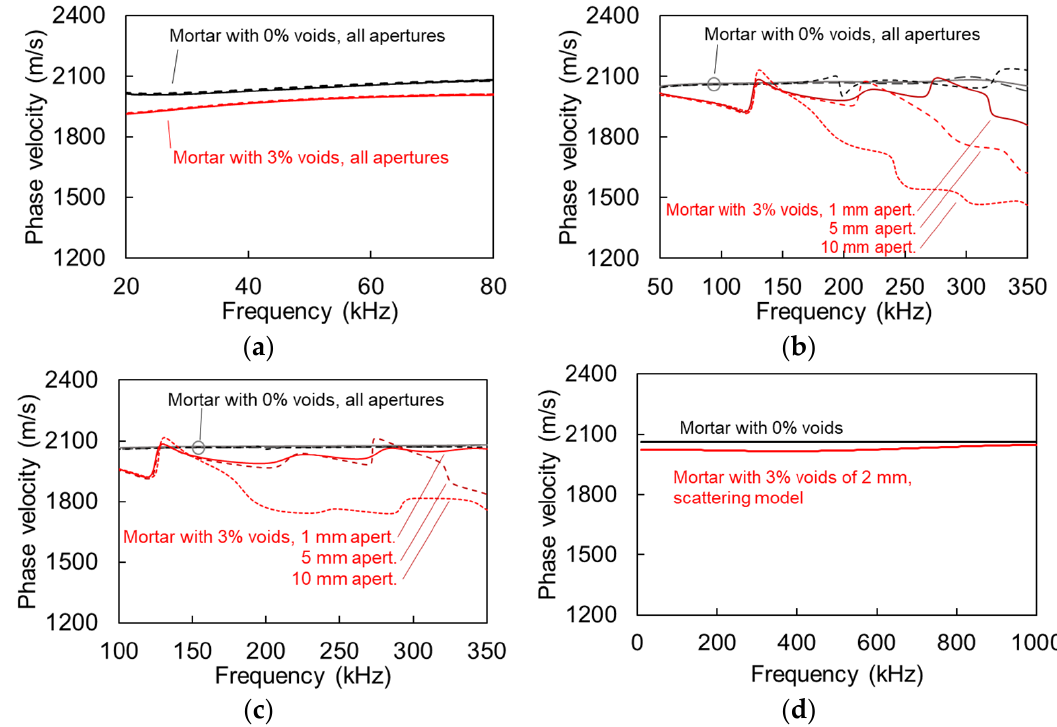
Figure 7. Rayleigh dispersion curves for mortar with 0% and 3% voids and excitation frequency of ( a ) 50, ( b ) 200, ( c ) 500 kHz, and ( d ) theoretical dispersion curve through scattering model.